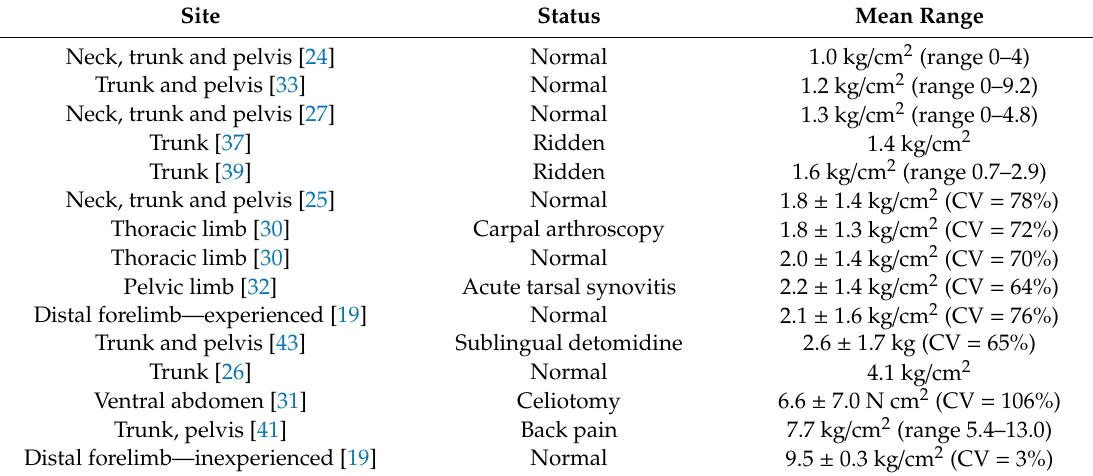
Table 4. Intra-examiner repeatability ranked across di ff erent body